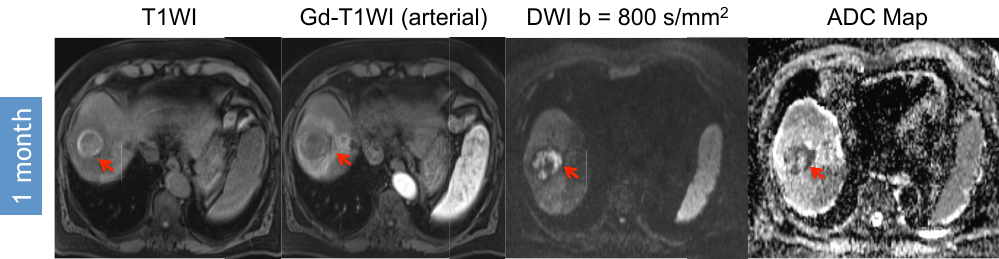
Figure 4. Hemorrhage causes “pseudo-restriction” on DWI. 62-year-old man with segment VIII HCC (arrow) without macrovascular invasion or extra-hepatic disease who underwent radioembolization segmentectomy therapy. There is no Gd-enhancement on one month post-procedural MRI. However, there is significant hyperintensity on pre-contrast images. Although the absence of enhancement correlates with absent diffusion restriction, the presence of hemorrhage creates “pseudo-restriction” without the presence of viable tumor. This pitfall has to be